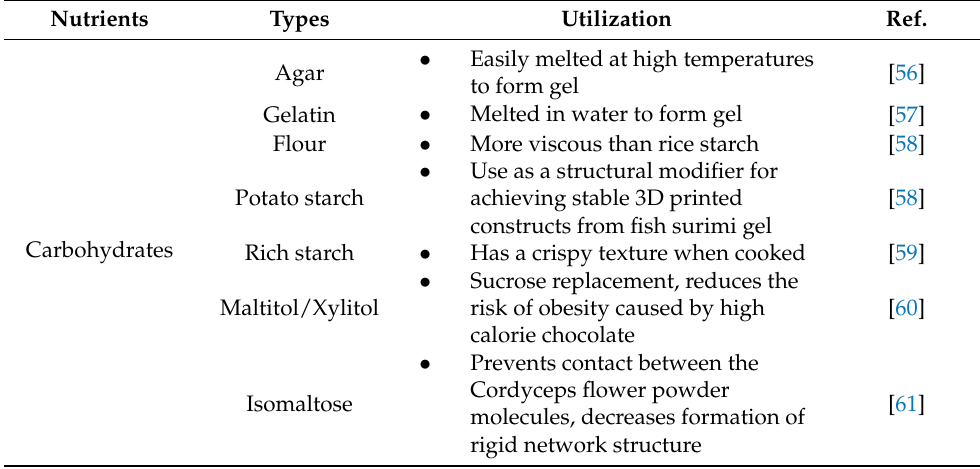
Table 3. Various nutrients and food viscosity agents utilized for 3D printing